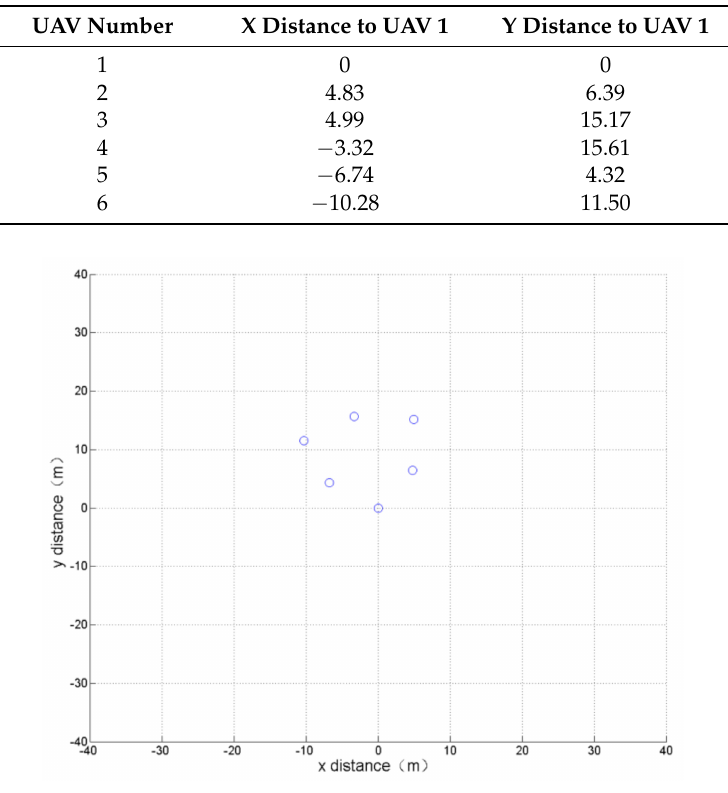
Figure 8. Formation optimization results of minimum